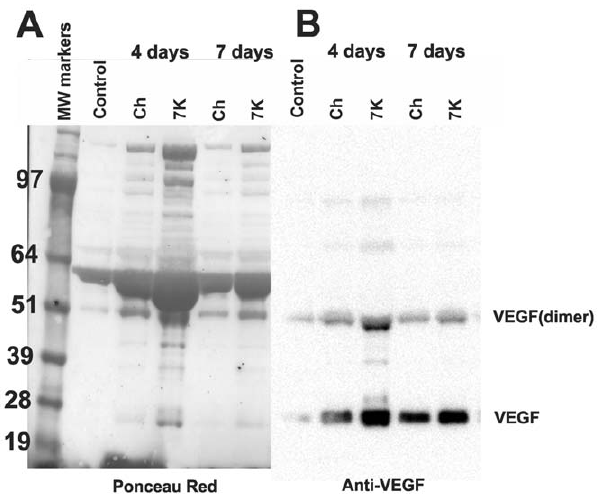
Figure 8. SDS-PAGE and immunoblotting of AH from Ch and 7KCh implants. AH (5 m l) from control (un-implanted eye), Ch and 7KCh implanted eyes were separated by SDS-PAGE and blotted. A. Ponceau S red stained blot demonstrating the difference in protein content between samples. B. Anti-VEGF labeling of blot.